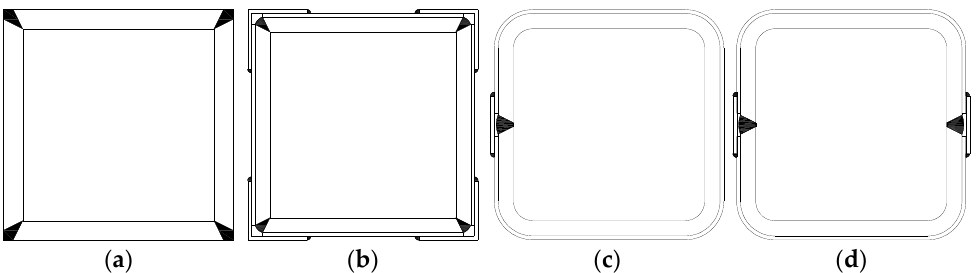
Figure 2. Different cross-sectional types of box-shaped TC bimetallic steel members. ( a ) Conven- tional four-corner-weld cross-section for steel member, ( b ) Updated four-corner-weld cross-section for TC bimetallic steel member, ( c ) Cold-formed cross-section for TC bimetallic steel member, ( d ) Doubly-U-shaped cross-section for TC bimetallic steel member.